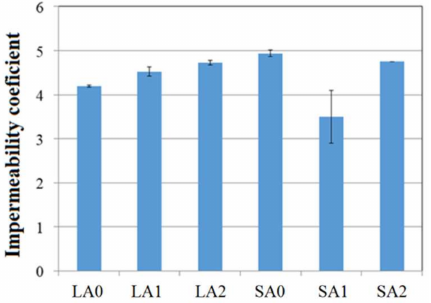
Figure 6. Impermeability of the investigated mortars at 180 days of curing.